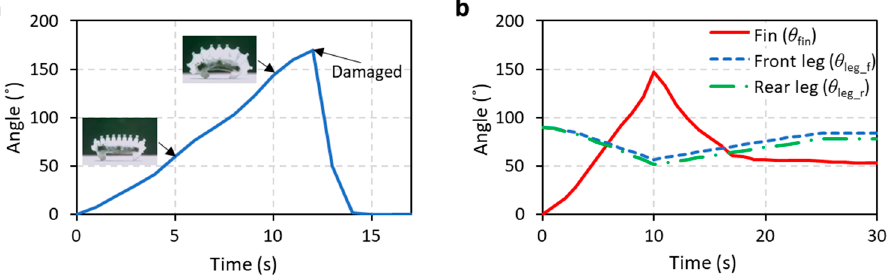
Figure 6. Measured fins and legs angles indicating appropriate heating and cooling time. ( a ) Arc angle formed by fins while WIBot is continuously heated. If the angle exceeds 160°, the robot incurs damage owing to excessive pressure. ( b ) Angles of fins and legs during heating for 10 s and subsequent cooling for 20 s. The leg angle represents the acute angle between the ground and the leg.